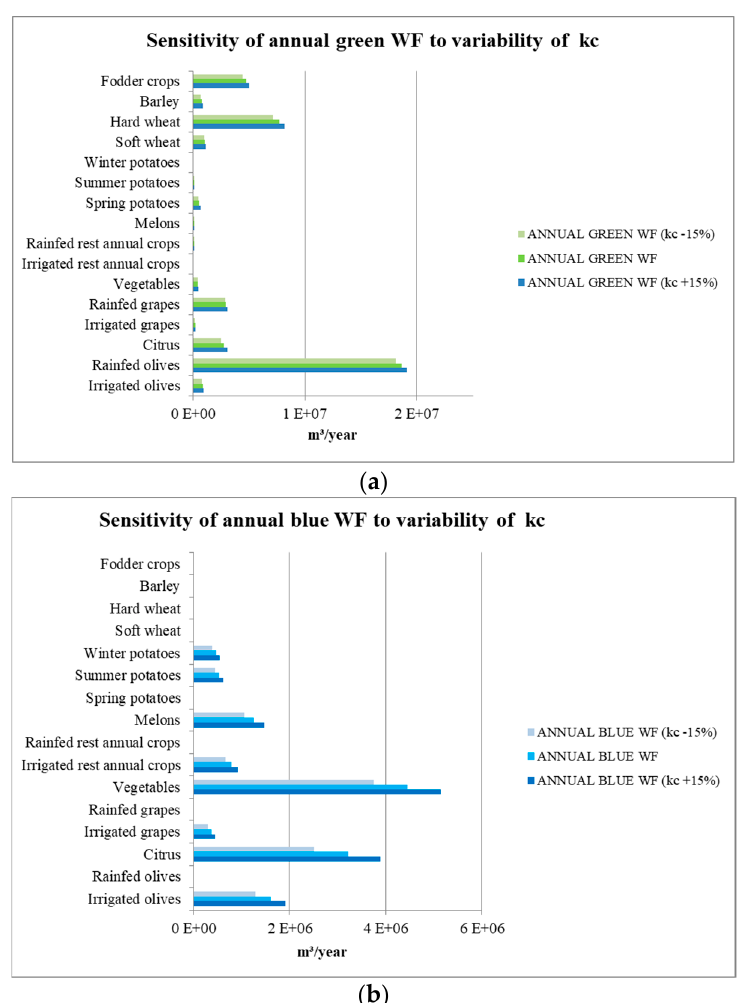
Figure 9. Sensitivity of annual WF (m 3 year − 1 ) to ± 15% variability of kc : ( a ) annual green WF and ( b ) annual blue WF.